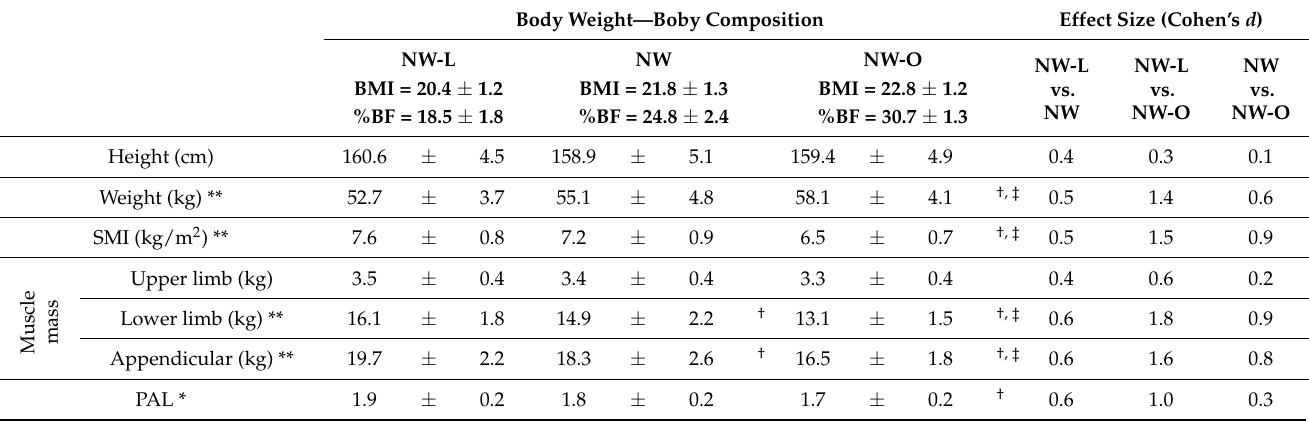
Table 2. Means and standard deviations of NW-L, NW and NW-O for each variable. Body Weight—Boby Composition Effect Size (Cohen’s d ) NW-L